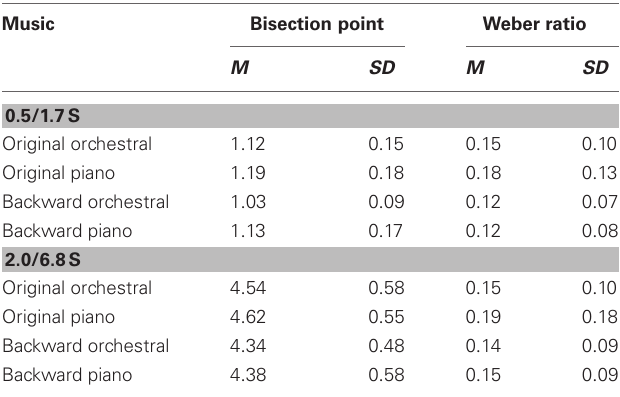
Table 4 | Means and standard deviation of the Bisection Points and Weber Ratios for original × backward and orchestral × piano music in the 0.5/1.7 and the 2.0/6.8s duration